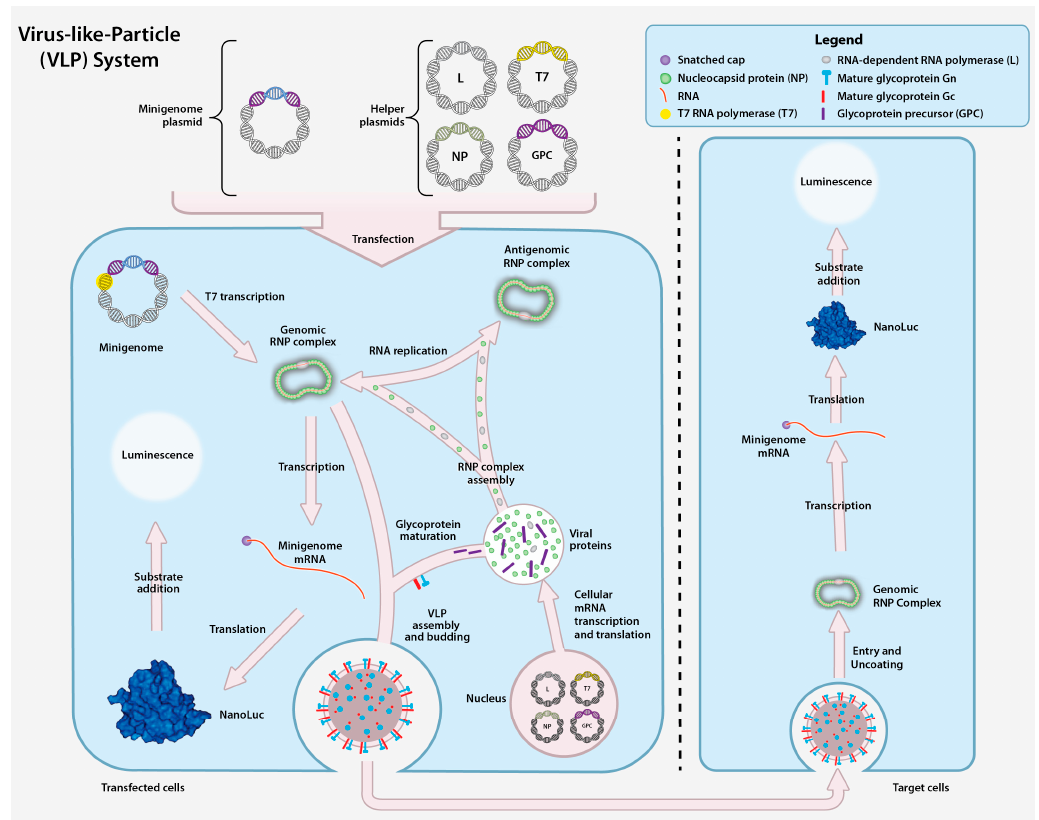
Figure 6. Transcriptionally and entry competent CCHF Virus ‐ like ‐ Particle (tec ‐ VLP) system. The